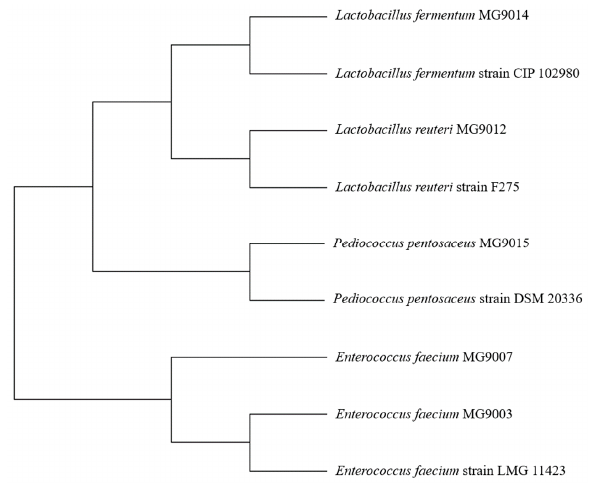
Figure 2. Phylogenetic analysis of selected strain based on bacterial 16S rRNA gene sequences. The selected strains were identified as regular rods and include shorter forms and extended cells (Figure 3). Probiotics are known to modulate the redox state of hosts through chelating capabilities, bioactive compound production, antioxidant enzymatic systems, and antioxidant signaling pathways, and they protect hosts from oxidative stress through specific molecular mechanisms.